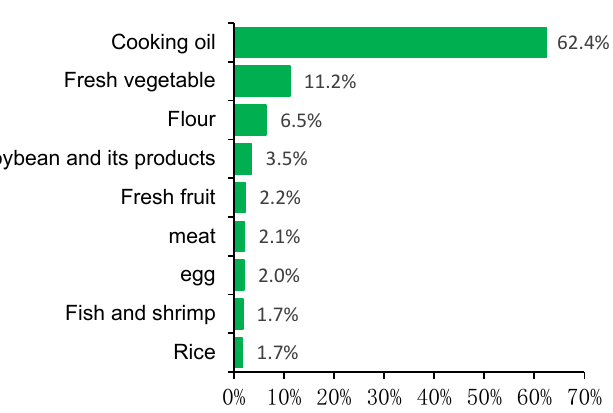
Figure A1. The main food source of vitamin E among non ‐ pregnant and non ‐ lactating women aged 18 to 49 in China.